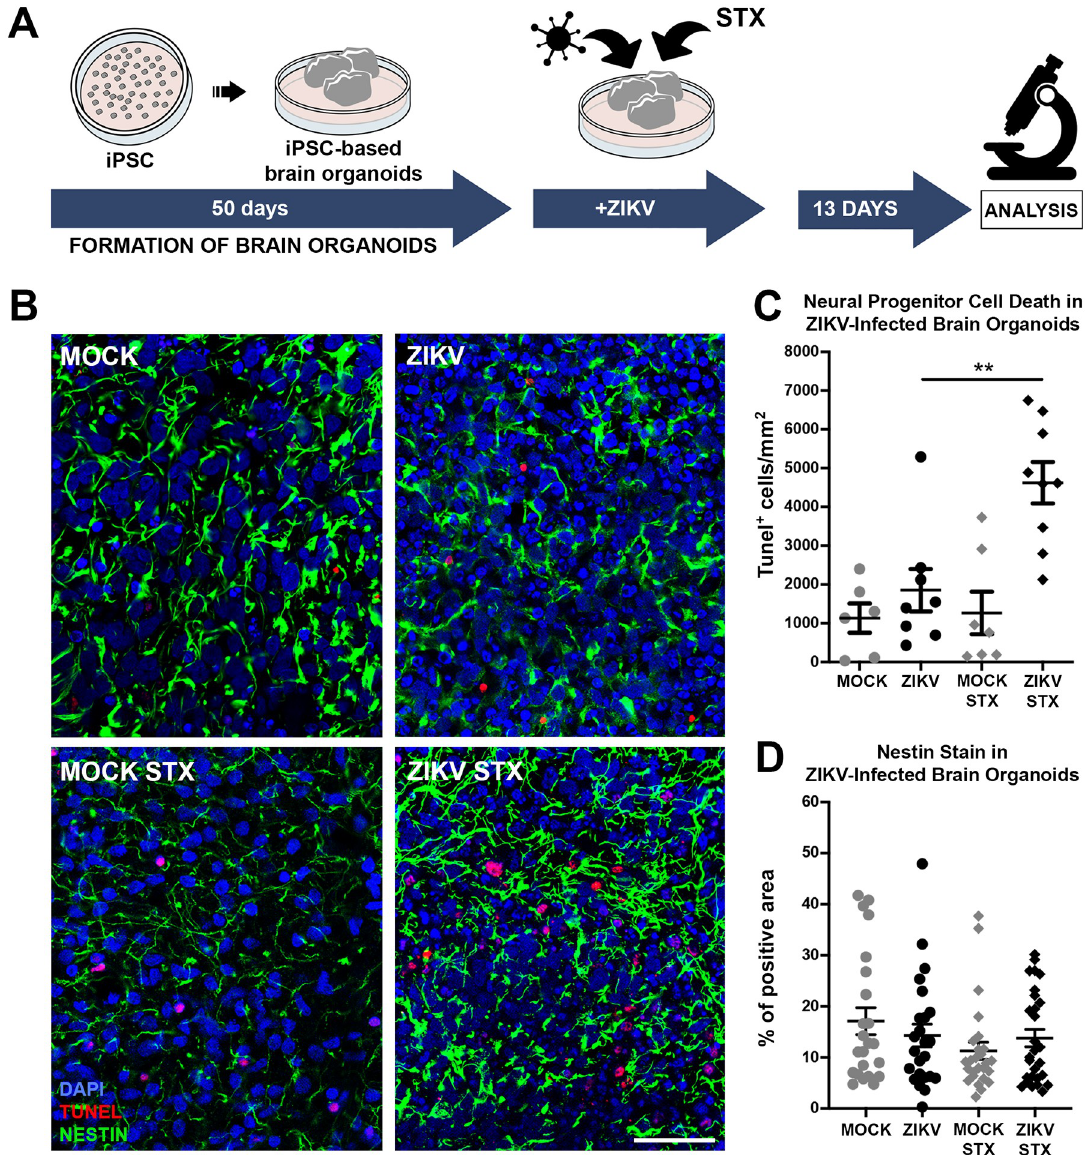
Fig 2. Saxitoxin increases cell death in ZIKV-infected brain organoids. 50-day-old brain organoids were infected with ZIKV and then exposed to STX for 13 days. (A) Summary of the experimental timeline. (B) Representative images of Nestin-positive areas (green) and TUNEL-positive cells (red) of untreated or STX-treated Mock and ZIKV-infected organoids. Scale bar means 50 μ m. (C) Number of TUNEL-positive cells per Nestin-positive brain organoid areas (mean ± SEM). ANOVA, �� p < 0.01 (D) Percentage of Nestin-positive area per slices of brain organoid in the experimental groups (mean ±